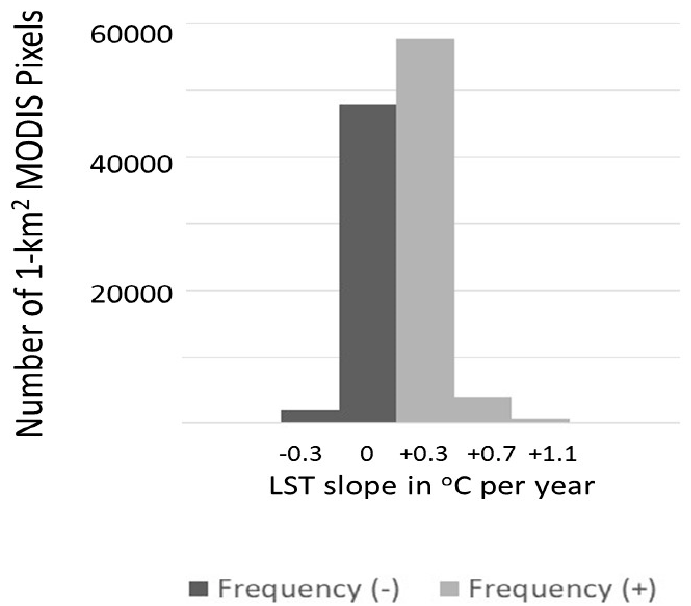
Figure 12. Distribution of LST slopes for all pixels with zero breakpoints detected from BFAST analysis in the DRECP study area between 2000 and 2018 for the MODIS 1-km time series.